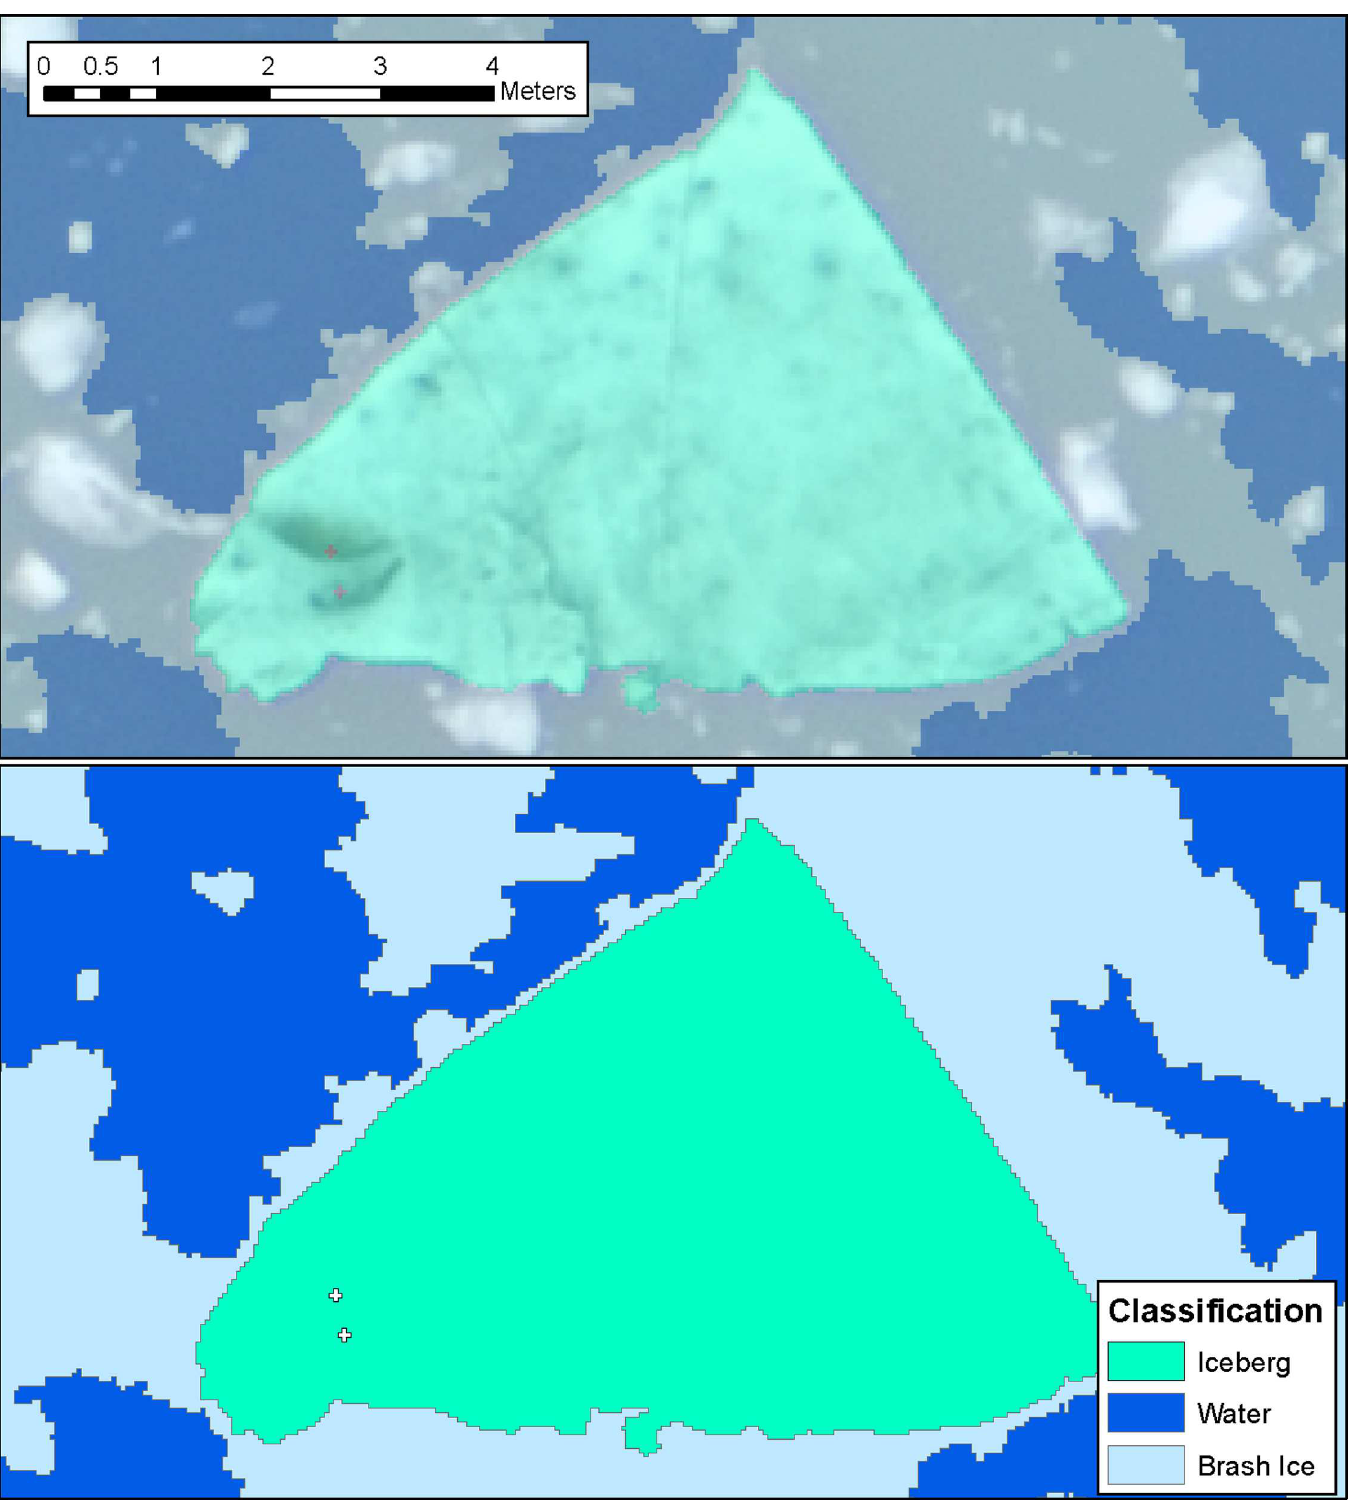
Fig 3. Sample classification result for the OBIA workflow. Classification, showingan iceberg, brash ice, water, and seals, is overlaid on originalimage. The icebergon which the two seals are resting has an area of 27.4 m 2 and an angularityof 1.51.